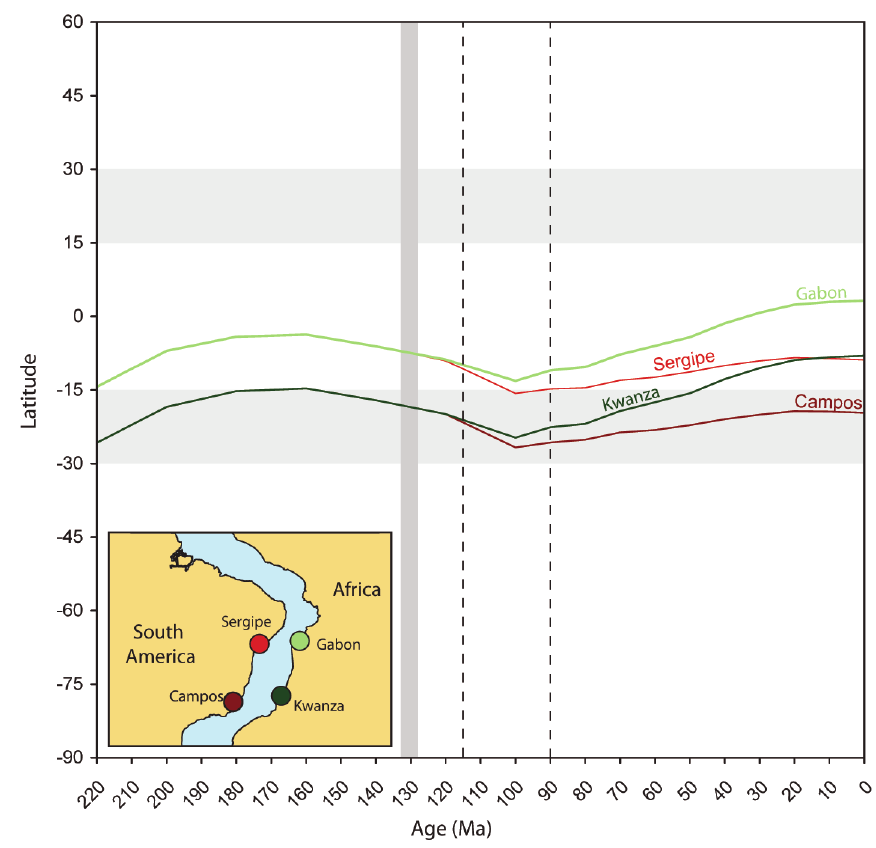
Fig. 2 – Relative motions of conjugate basins that diverged during the opening of the South Atlantic. The conjugate basins are the Sergipe (Brazil)-Gabon and the Campos (Brazil)-Kwanza (Angola). The Albian fossil localities of the Santana Formation, Brazil, are northwest of the Campos Basin. The Kwanza Basin contains the Turonian locality of Iembe. The inset map shows the position of basins during the early phase of opening of the South Atlantic Ocean. The gray shading indicates rifting at the paleolatitude of the Kwanza Basin (132-128 Ma); the dashed vertical line on left (115 Ma) indicates marine sediments in the Sergipe Basin and initiation of a shallow Equatorial Atlantic Gateway; vertical dashed line at 90 Ma indicates completion of a deep Atlantic Equatorial